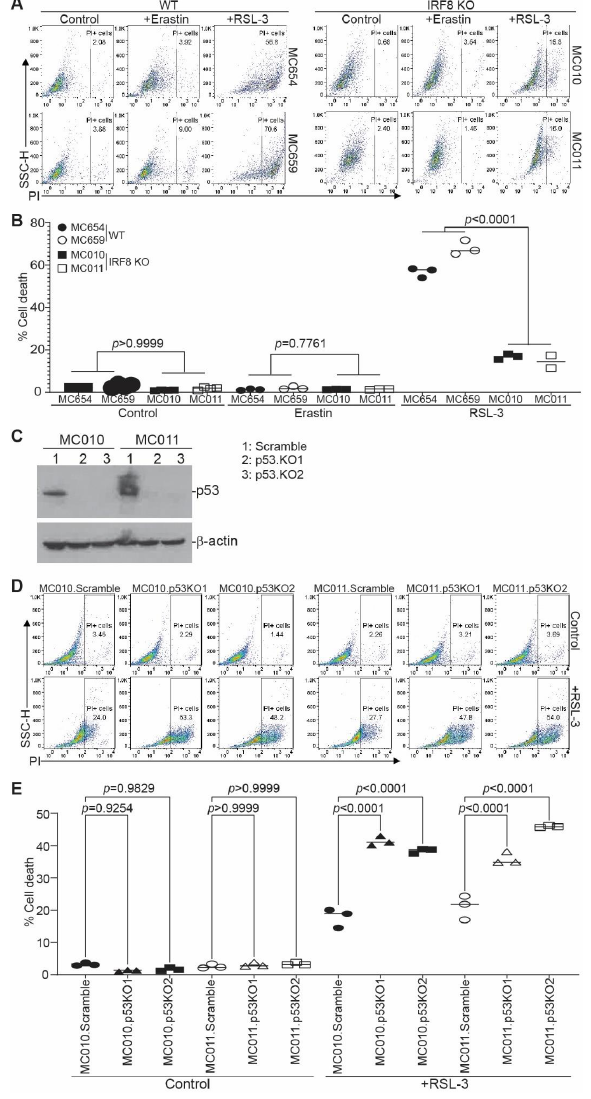
Figure 3. IRF8 regulates intrinsic ferroptosis in tumor cells. ( A ) Tumor cells were cultured in the presence of erastin (20 μM) and RSL-3 (0.1 μM) for approximately 24 h. Cells were collected, stained with PI,